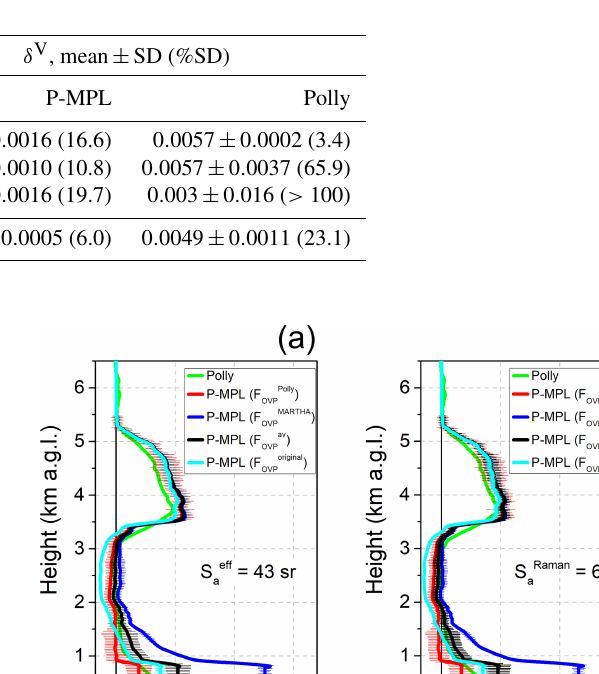
Table 2. Mean VLDR values together their standard deviation (SD) (and their relative SD error, in %) as obtained from the P-MPL and Polly